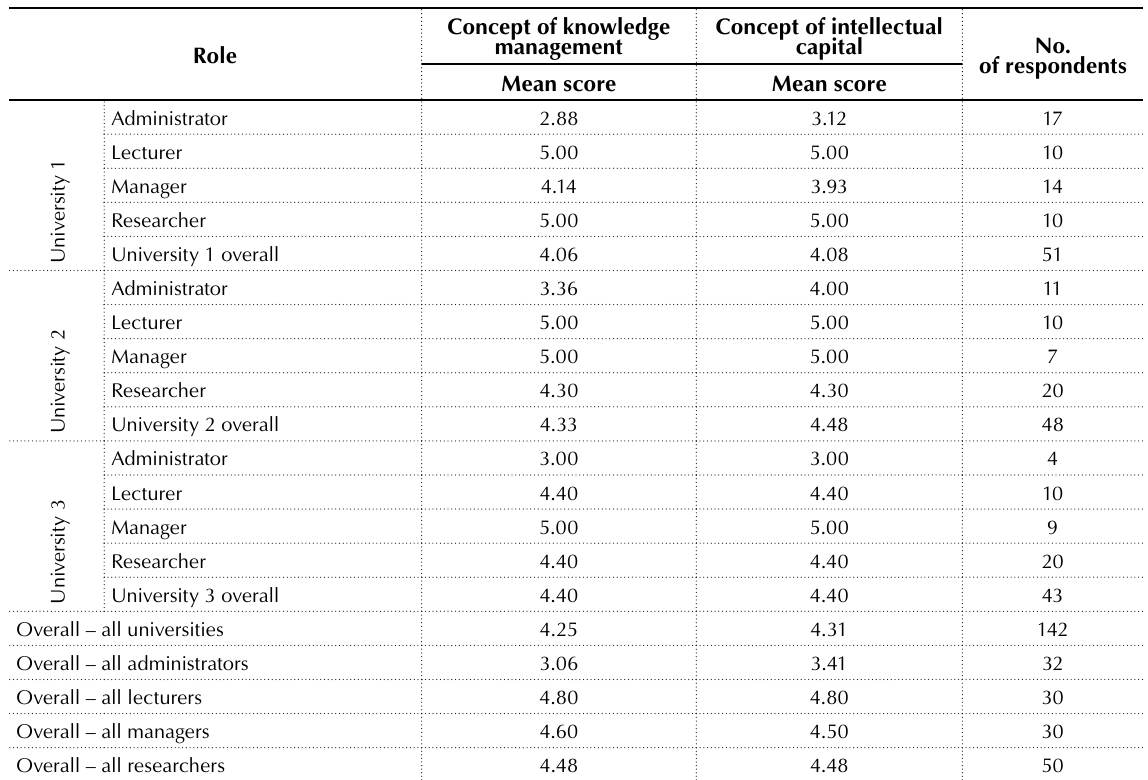
Table 3. Mean scores – levels of understanding of concepts (5 = highest level of understanding, 1 = lowest level of understanding)